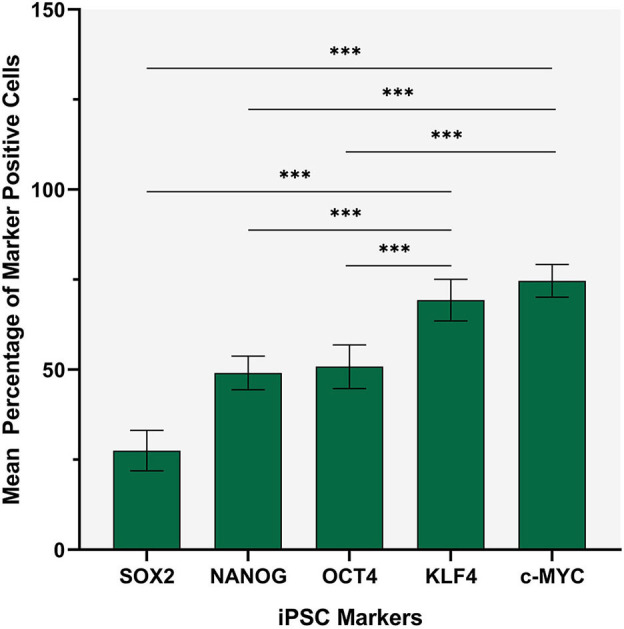
Statistical analysis of cell counting for in situ hybridization stained slides demonstrating that c-MYC had the highest mean proportion of positive cells, followed by KLF4 although there was no statistically significant difference between them. OCT4 and NANOG had lower mean proportions of positive cells compared with c-MYC and KLF4 although there was no statistically significance difference between them. The mean proportion of cells that stained positively for SOX2 was significantly lower (p < 0.0005) than the other four iPSC markers. Error bars: 95% confidence interval. ***p < 0.05.